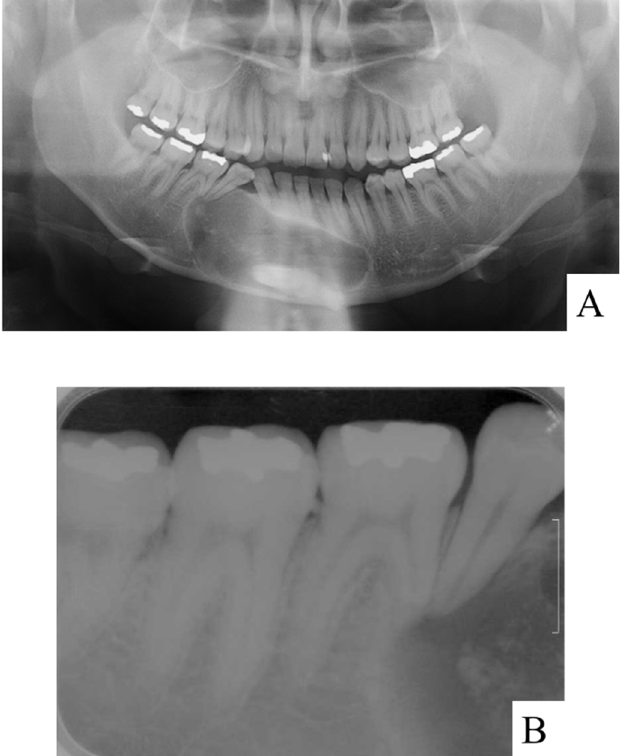
Fig. 1. A slight swelling on the right side of the mandible in comparison with the opposite side. Fig. 2. Panoramic radiograph showed a well-de